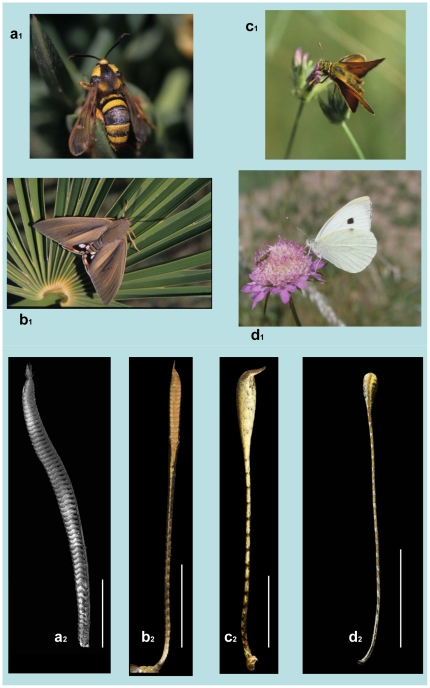
Butterflies, sesiid and castniid moths:
a1, the hornet clearwing Sesia apiformis (a sesiid), b1, the palm borer Paysandisia archon (a castniid), and two butterflies: c1, the large skipper, Ochlodes venatus, and d1, the large white, Pieris brassicae, with their respective male antennae, a2, b2, c2, d2, seen ventrally. Antennal pectinations are only present in the sesiid male, where the olfactory sensory surface (OSS) covers all the ventral side of the antenna. In castniids and butterflies the club forms rather distally and the OSSs are greatly reduced with a clear tendency to concentrate on the club. Scale bars: 2 mm for a2, c2; 5 mm for b2, d2.